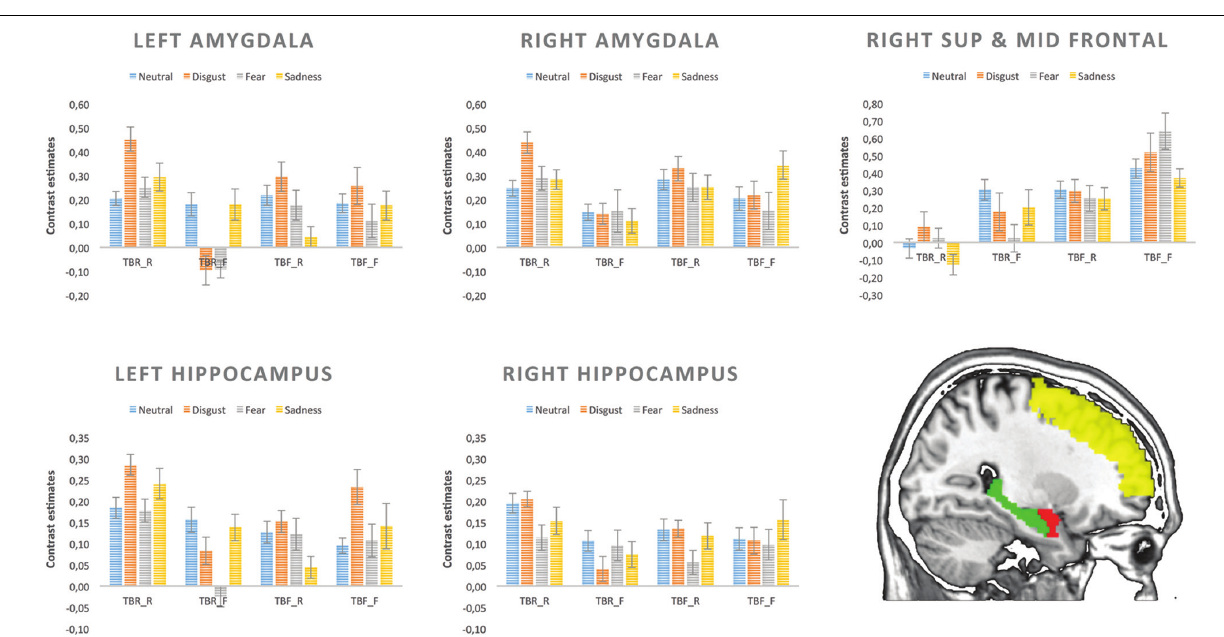
FIGURE 6 | Contrast estimates extracted for each condition from five regions of